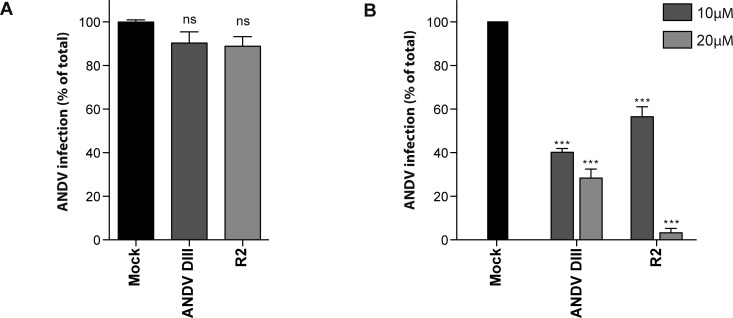
Exogenous DIII and stem fragments block the virus-cell membrane fusion process.(A) Incubation for 1 h of Vero E6 cells with exogenous DIII and stem fragments at 10 and 20 μM, respectively, followed by washing and subsequent inoculation with ANDV. (B) Inhibition of the fusion of ANDV with the plasma membrane by exogenous DIII and stem fragments. The Gc fragments or controls were added during the 5 min low pH incubation step. The statistical evaluation of each data point was performed in relation to the Mock treatment: ***, P < 0.00025; **, P < 0.0025; *, P < 0.025; ns, not significant.